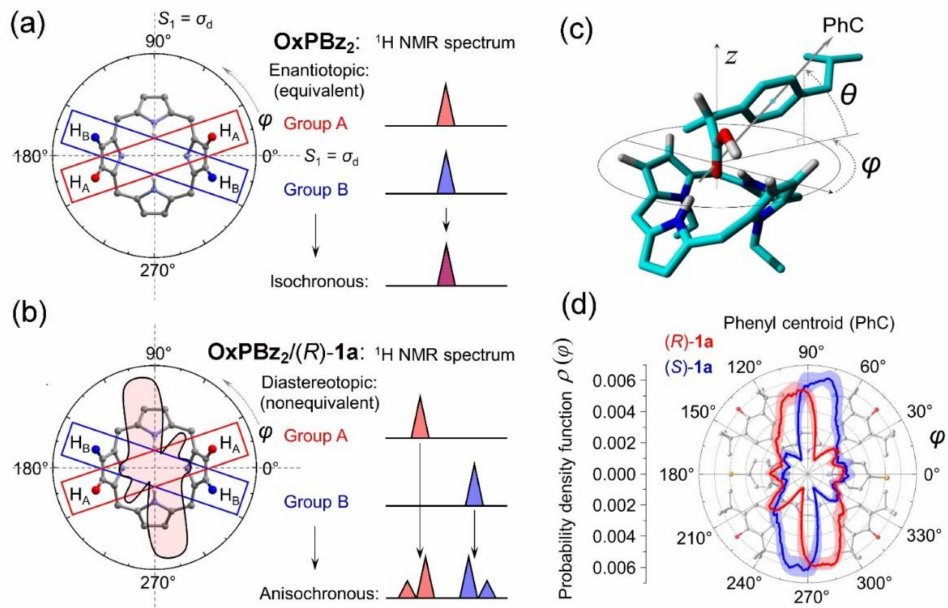
Figure 7. ( a ) Symmetry scheme of uncomplexed OxPBz 2 host molecule and the corresponding shape of NMR spectra of pyrrolic reporting protons A and B. ( b ) Symmetry scheme of OxPBz 2 host complexed with ( R )- 1a with resulting nonequivalent A and B protons due to the symmetry breaking upon the complexation. The dissymmetrizing “chiral field” (light red shading) induced by ( R )- 1a was calculated by molecular dynamics (MD) in (c,d). Corresponding NMR spectral pattern of A and B protons is also shown. ( c ) The reference system ( φ and θ ) of OxPBz 2 and 1a used for MD calculation. ( d ) Plots of probability density functions ( φ components) as obtained from MD for OxPBz 2 · ( R )- 1a (red line) and OxPBz 2 · ( S )- 1a (blue line) complexes. Adapted with permission from Ref. [43]. Copyright 2013 Labuta et al. Published by Springer Nature under a Creative Commons Attribution 3.0 International License http://creativecommons.org/licenses/by/3.0/ (access date: 6 September